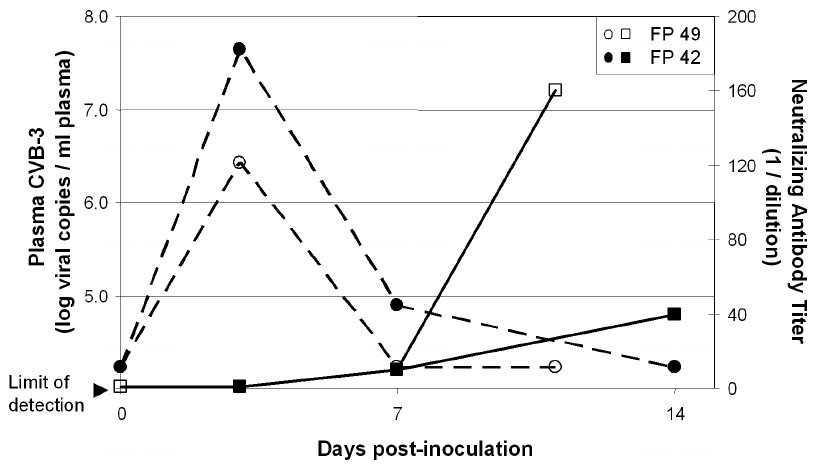
Figure 1. Coxsackievirus viral load (plasma viral RNA copies/ml) (dashed lines) and neutralizing antibody titers (reciprocal of dilution) (solid lines) after intravenous infection of two cynomolgus monkeys: FP42 (closed figures) and FP49 (open figures).